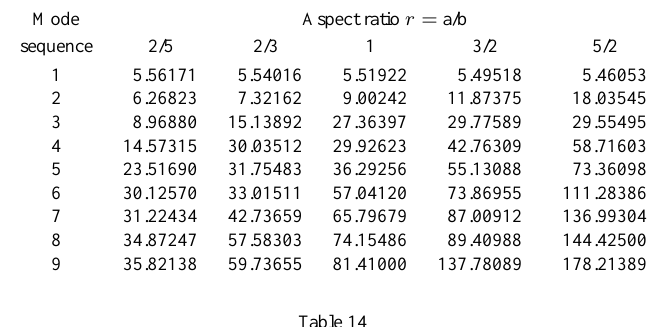
Table 13 Bicubic B-spline solutions of frequency parameters for CFGF plates